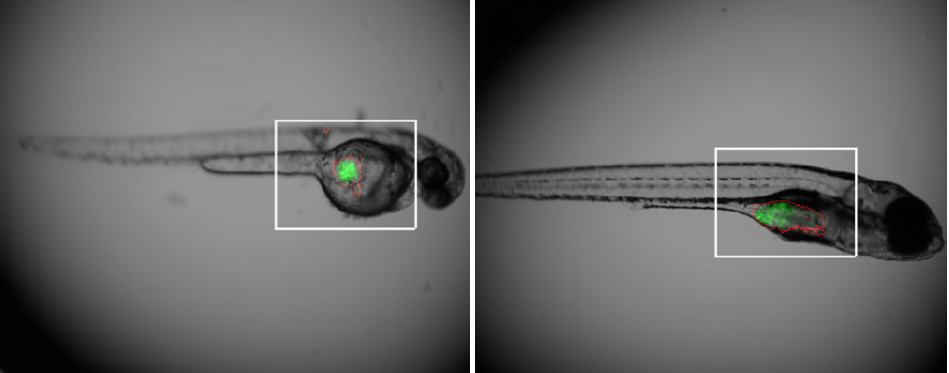
Figure 1. Example of segmentation over a characteristic image (zebrafish #8 at 0 hpi and 72 hpi) where the GFP value and the contour image are overlaid in green and red, respectively. The white rectangle will be the region of interest in the next